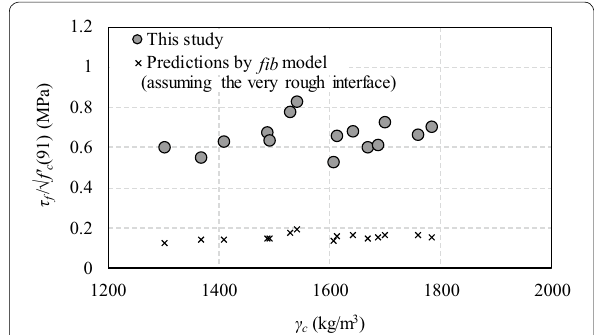
Fig. 11 Effect of γ c on the shear friction strength of the LWAC‑BS.